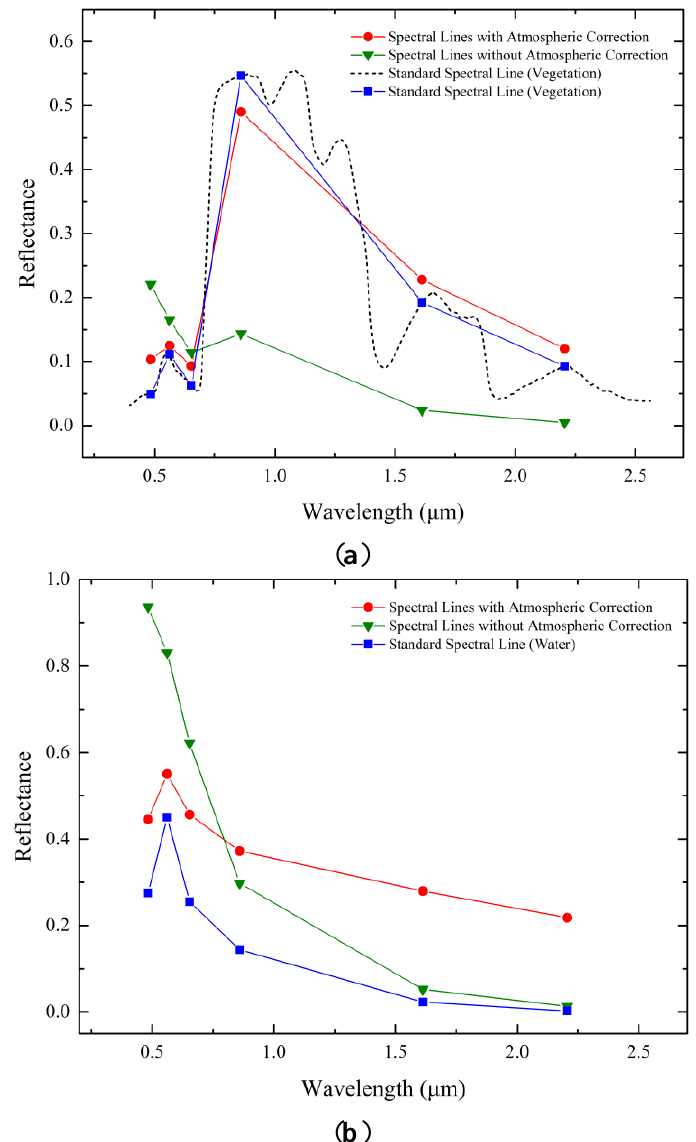
Figure 2. Comparison between spectral lines with and without atmospheric correction on 21 May 2013. ( a ) Spectral lines of vegetation. The standard spectral line (Vegetation) was obtained from the ASTER Spectral Library; ( b ) Spectral lines of water. The standard Spectral Line (Water) was obtained from Yao